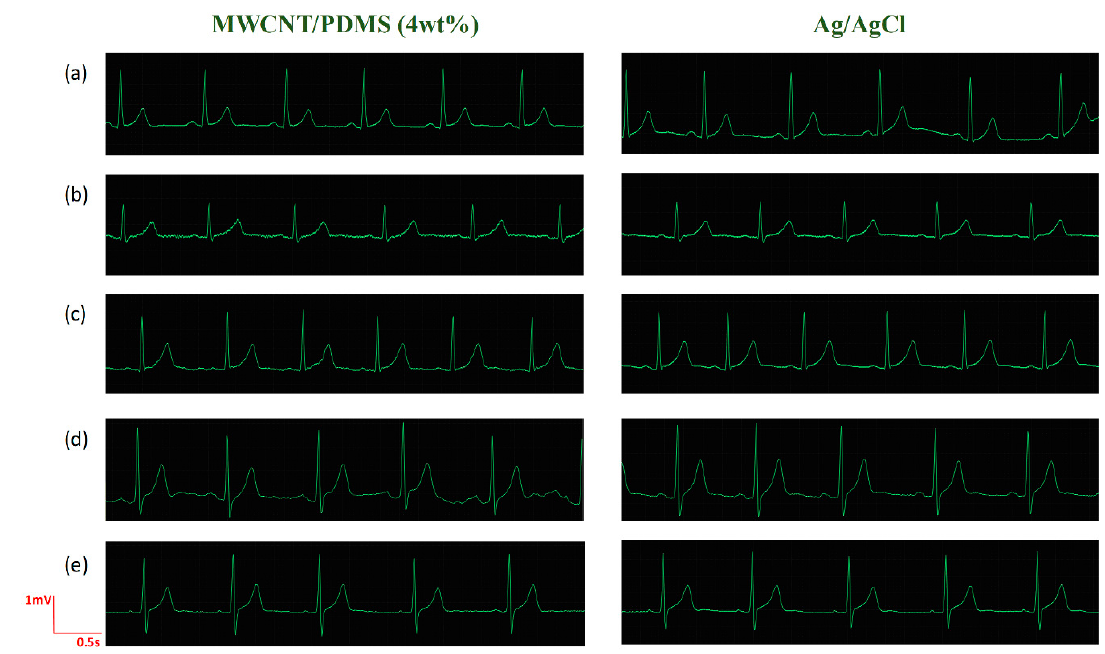
Figure 7. ECG signals of five subjects under resting state for 4 wt% MWCNT/PDMS electrodes and Ag/AgCl electrodes. Subjects: ( a ) male aged 38, ( b ) female aged 31, ( c ) female aged 24, ( d ) male aged 23, ( e ) male aged 18.